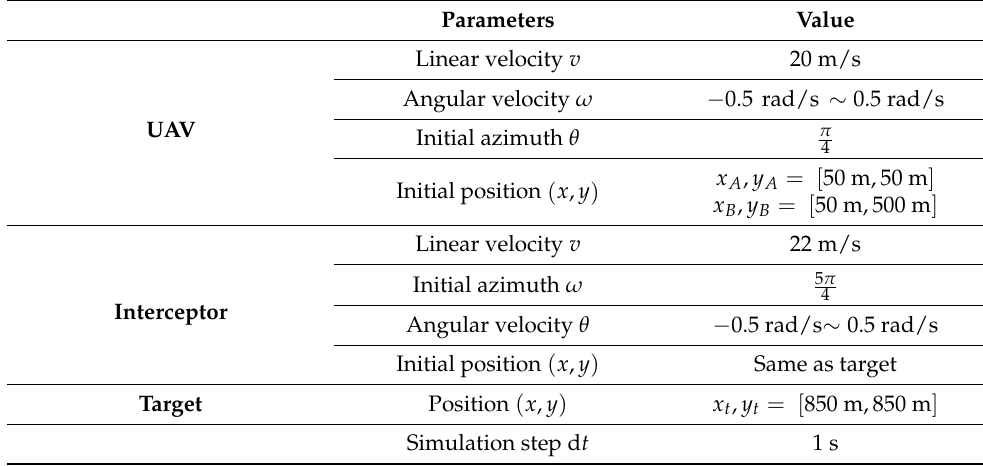
Table 1. Simulation